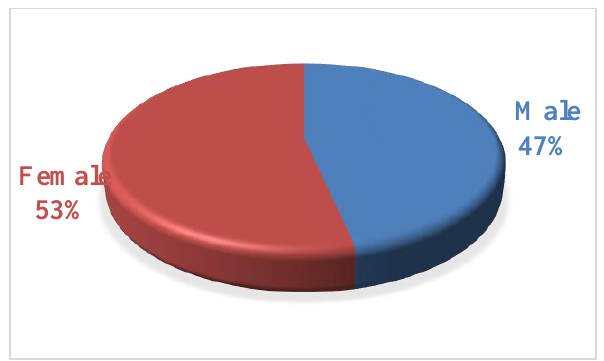
Fig-5: Distribution of injured children by sex,n= 234 Fig-5 shows distribution by sex of injured female were 125(53.4%) and the rest 109 (46.6%) were male. Table 2: Distribution of respondents by place of injury,n=234 Place of injury